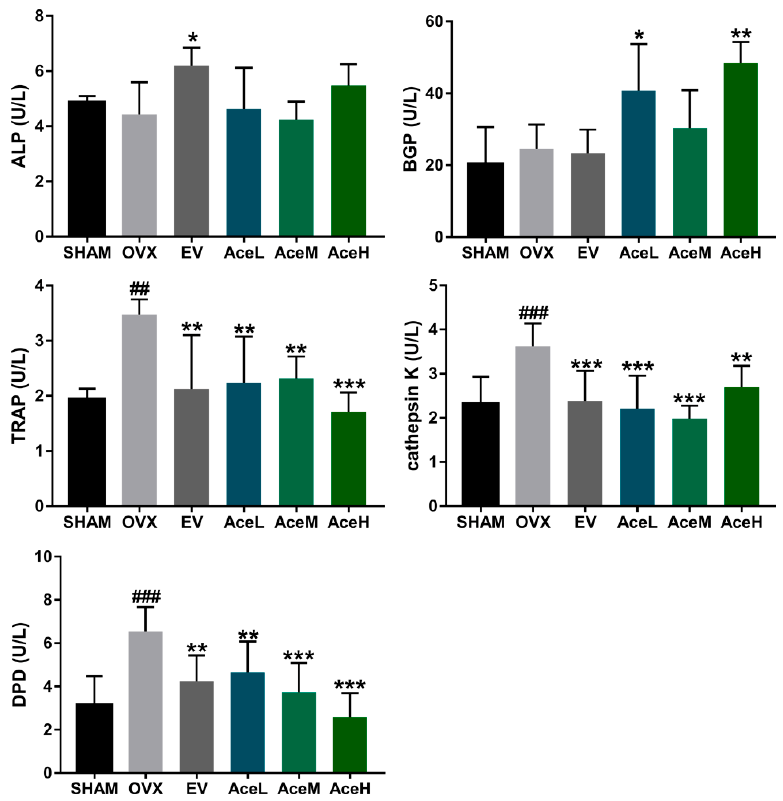
Figure 4. Acteoside treatment effectively prevented OVX - induced bone formation markers including ALP and BGP, and bone resorption indexes including TRAP, cathepsin K, and DPD activities ( n = 10); values were presented as the mean ± SD. * p < 0.05, ** p < 0.01, *** p < 0.001 relative to the mice of OVX model group; ## p < 0.001, ### p < 0.001 relative to the SHAM group.